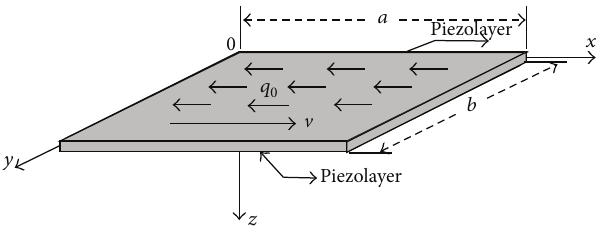
Figure 1: Configuration of axially moving viscoelastic plate with piezoelectric layers subjected to uniformly distributed tangential follower